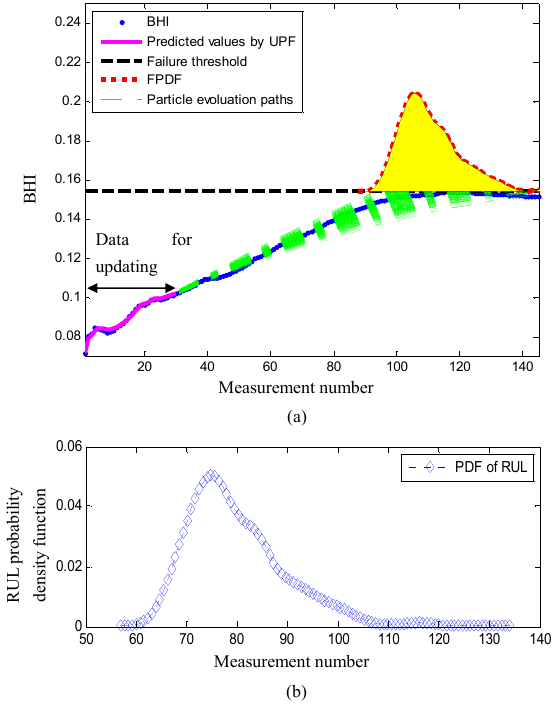
Figure 5. Bearing RUL prediction by using the proposed bearing prognostic method at measurement number 30. ( a ) The degradation trend; ( b ) the probability density function (PDF) of the RUL.